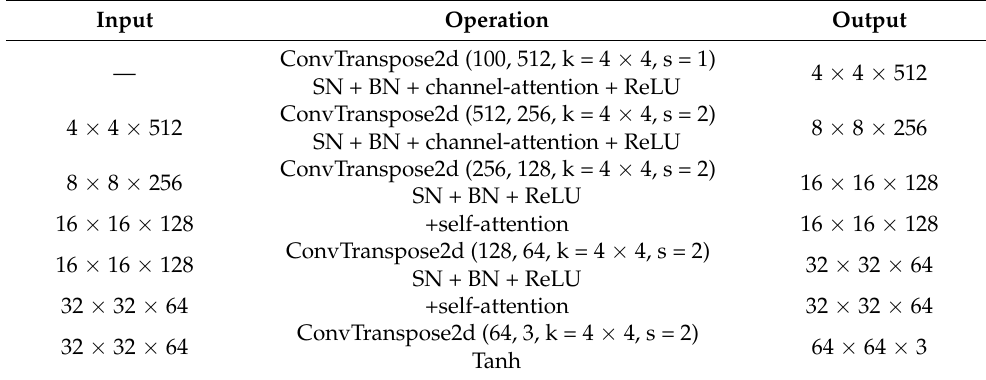
Table 1. The network structure of the generator in CelebA.